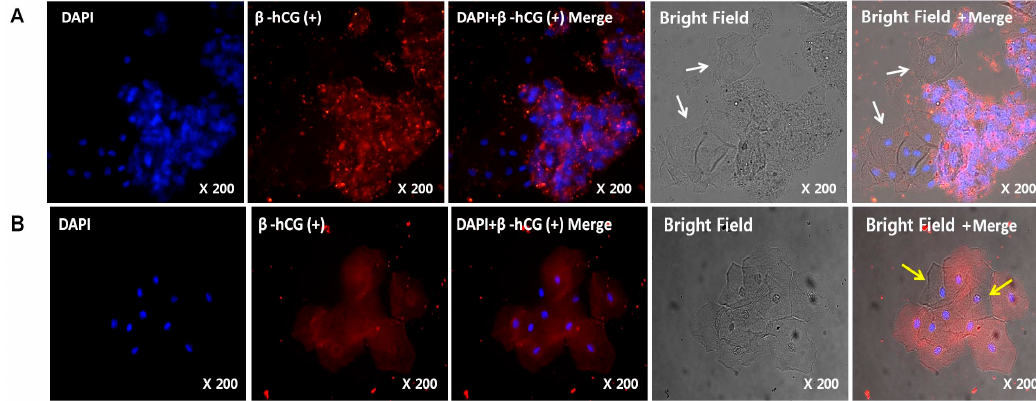
Figure 2. Expression of β -hCG in cells isolated using HLA-G coupled to magnetic nanoparticles after